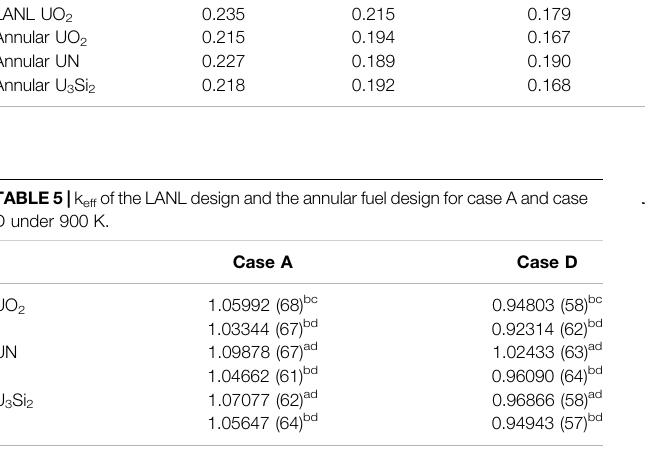
TABLE 4 | The standard deviation of relative fi ssion rate for each axial re fl ector condition under 900 K. Design